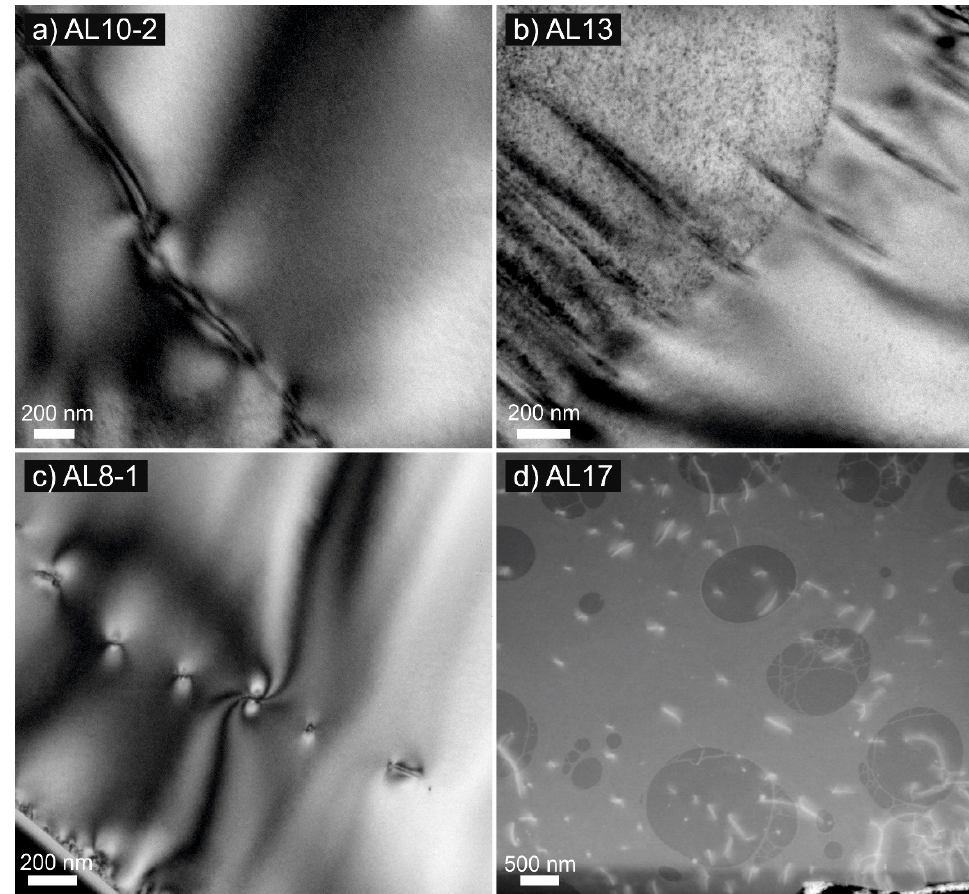
Figure 4. ( a – c ) Bright-field images and ( d ) an overview HAADF image of single dislocations in apatite crystals from banded iron formations (AL10-2, AL13) and metacarbonate rocks (AL8-1, AL17). Electron irradiation damages due to TEM operations are visible in the left upper part of AL13 image.